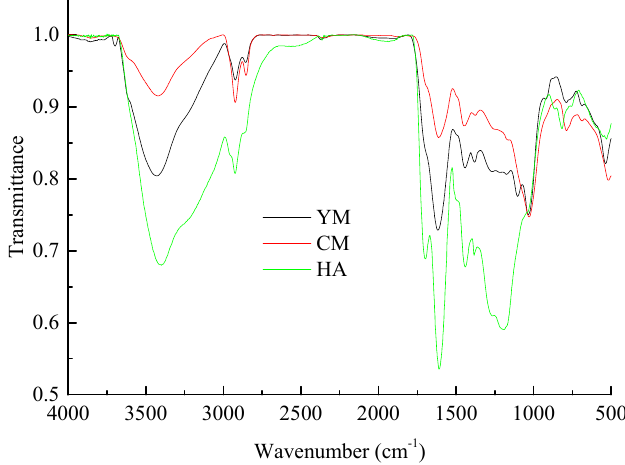
Figure 7. Fourier-transform infrared (FTIR) spectroscopy of YM, HA, and CY.